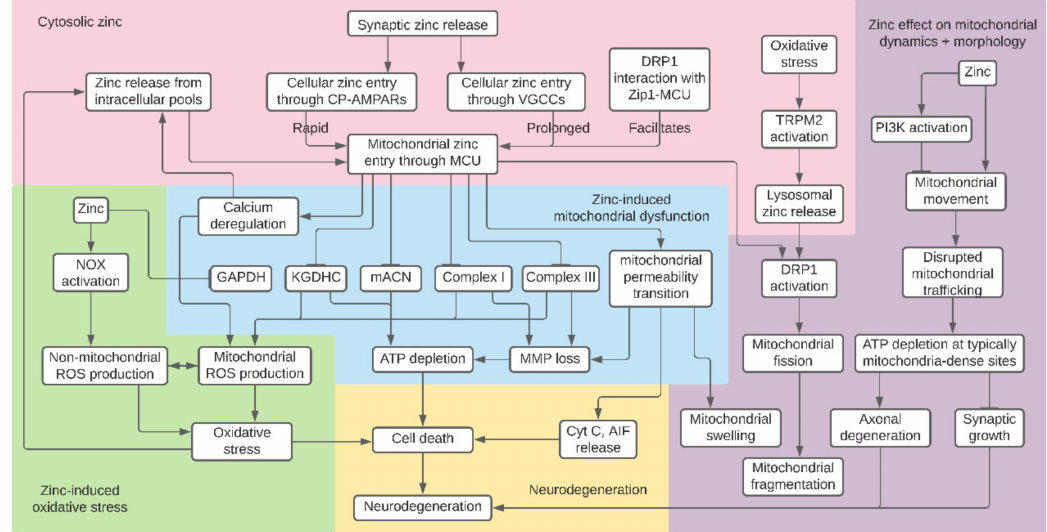
Figure 1. Summary of proposed mitochondrial effects of zinc. Synaptic zinc entry and release of zinc from cytosolic pools causes rises in intracellular zinc, which accumulates in the mitochondria. Zinc inhibition of components of glycolysis, the tricarboxylic acid (TCA) cycle, and the electron transport chain (ETC) result in mitochondrial membrane potential (MMP) loss and decreased ATP production. Other effects of excess zinc include reactive oxygen species (ROS) generation, mitochondrial permeability transition, and calcium deregulation. Finally, zinc inhibits mitochondrial movement and causes mitochondrial fragmentation by initiating excess fission. It is not clear if these pathways interact to induce their neurotoxic effects. Nevertheless, zinc-induced mitochondrial detriments may collectively result in cell death and